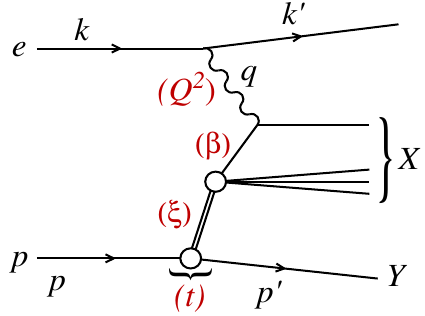
Figure 1: A diagram of a diffractive NC event in DIS together with the cor- responding